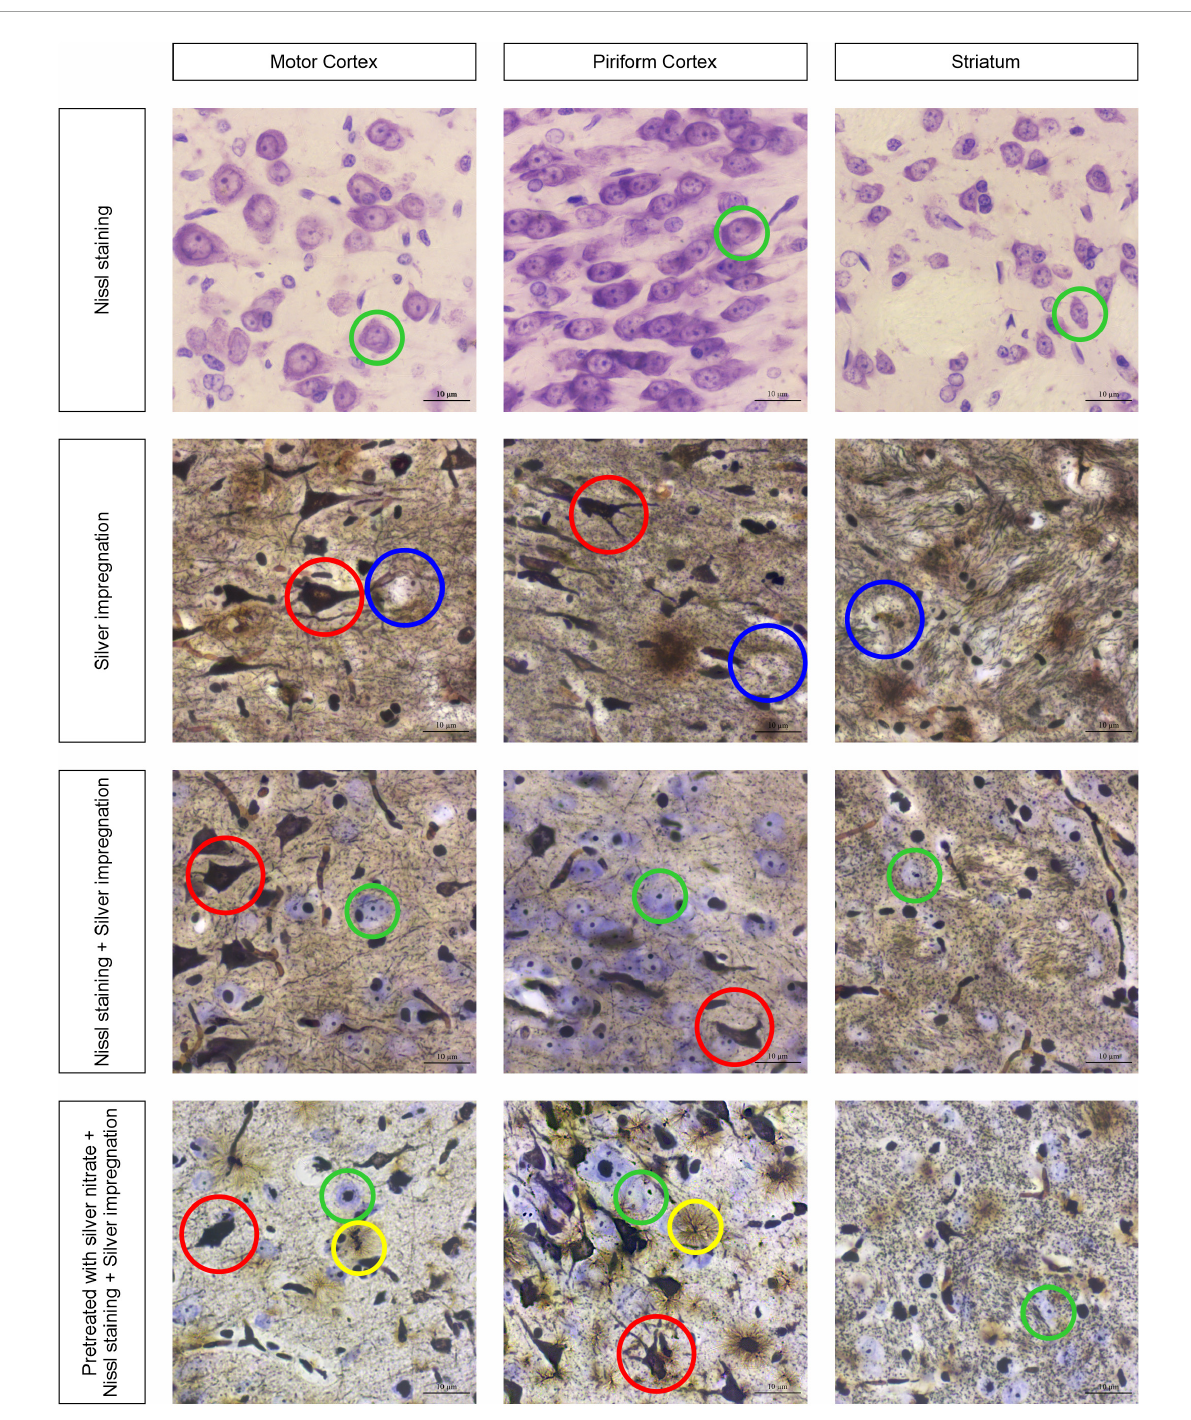
FIGURE1 Three brain regions, the motor cortex, the piriform cortex, and the striatum, stained with four different approaches: neurons with cresyl violet (green circles); neurons with silver nitrate (red circles); non-impregnated neurons (blue circles); and astrocytes (yellow circles). Ob. 63x, oc. 20x, scale bar: 10 µ